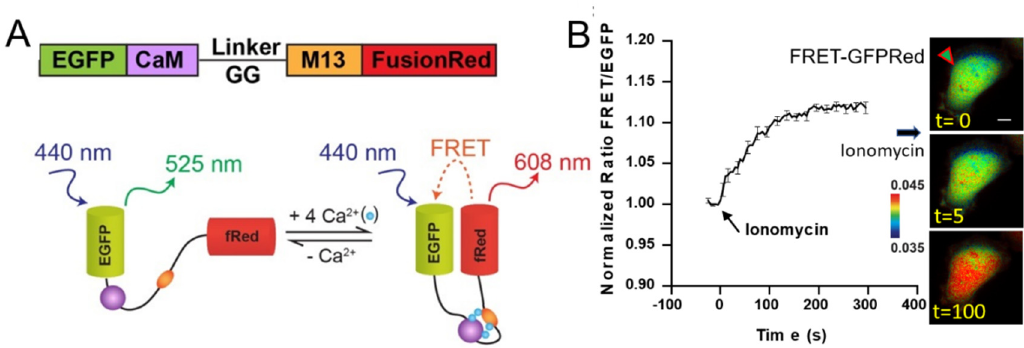
Figure 1. ( A ) A schematic diagram of a new fluorescence resonance energy transfer (FRET) biosensor (FRET-GFPRed). A new FRET-based Ca 2+ biosensor with EGFP and FusionRed fluorophores (FRET-GFPRed) was designed to show FRET between EGFP and FusionRed. FRET increases when calcium ions bind to Calmodulin (CaM) and M13, which provides dynamic readouts of intracellular calcium concentration. ( B ) Time course of the FRET / EGFP signal ratio. FRET-GFPRed expressing HeLa cells were stimulated with ionomycin. Images on the left represents before (t = 0 s), 5 s, and 100 s after ionomycin stimulation (1 µ M) in HeLa cells at t = 0 s. A green arrowhead surrounded by red lines indicates HeLa cells transfected with FRET-GFPRed. A scale bar represents 10 µ m. Error bars indicate ± one SEM.